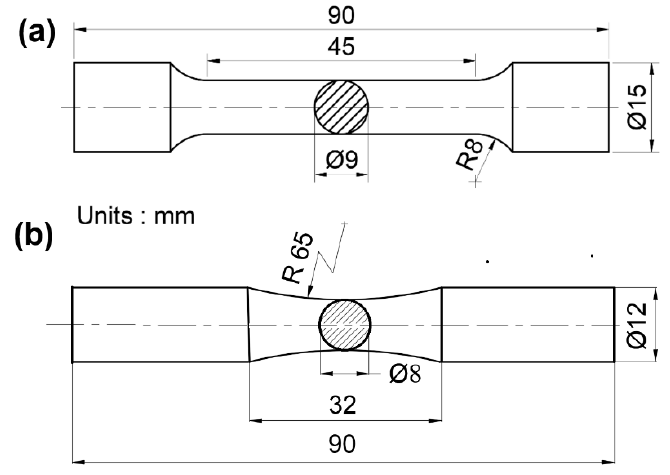
Figure 4. ( a ) Tensile test specimen according to ASTM E8/E8M and ( b ) fatigue